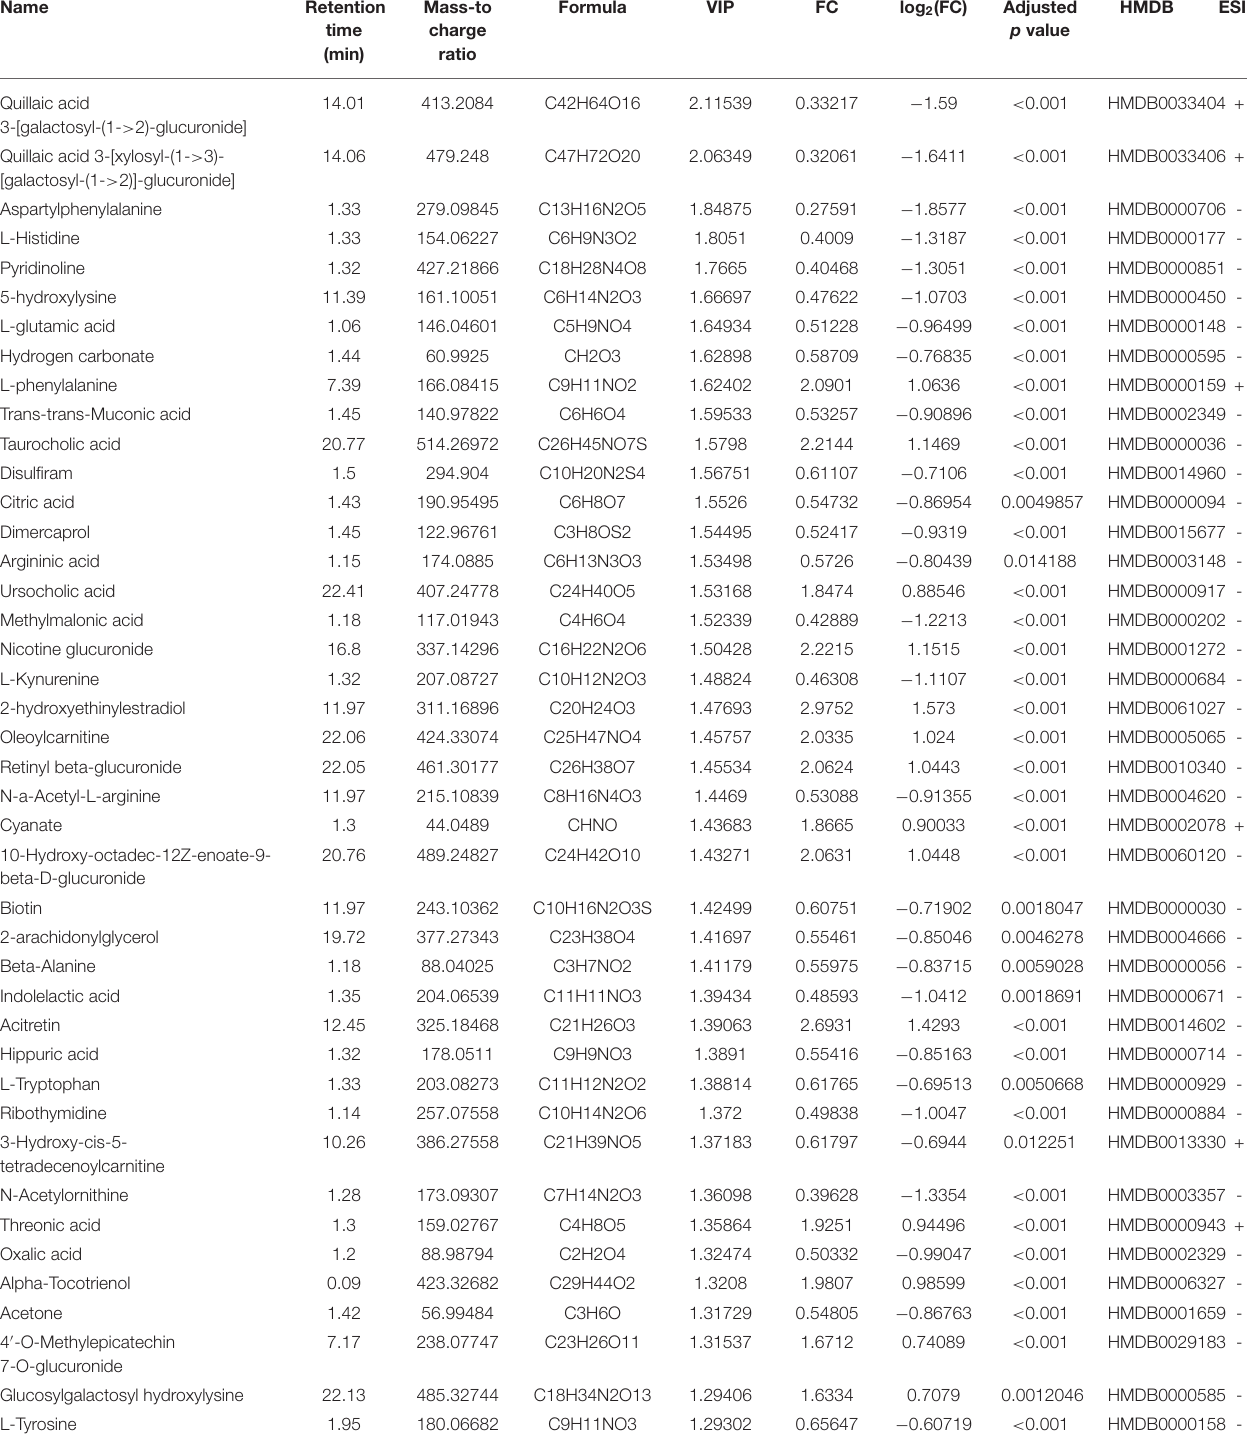
TABLE 2 | Differential metabolites in the serum of papillary thyroid cancer patients and healthy subjects with positive and negative ion